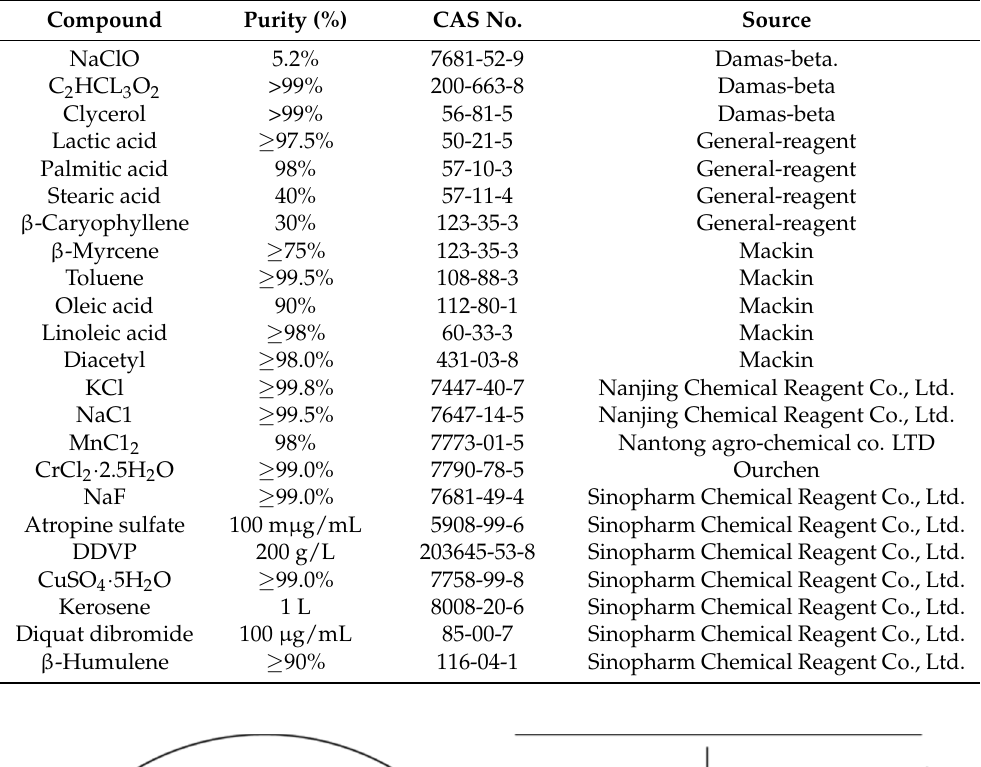
Table 1. Purity and sources of the chemicals used for chemical identification and laboratory and field assays.